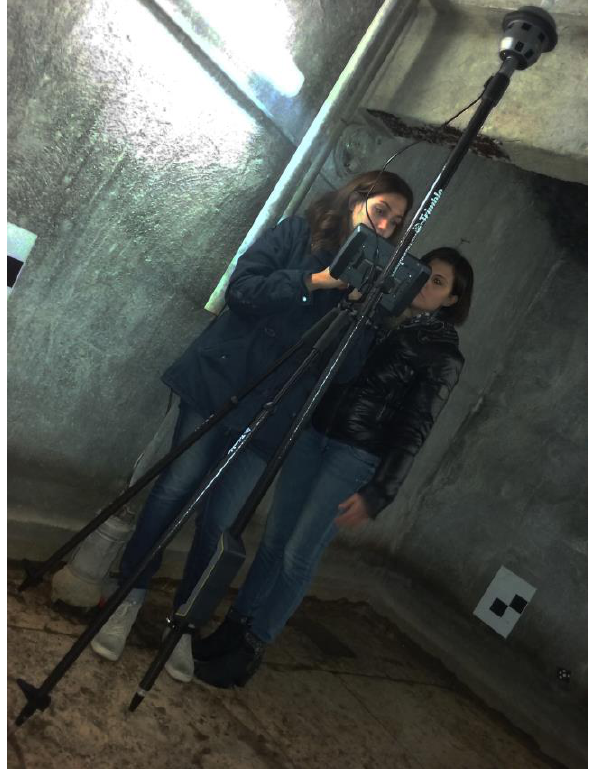
Figure 4. Trimble V10 Imaging Rover equipped with a 360 degrees prism on a topographic rod